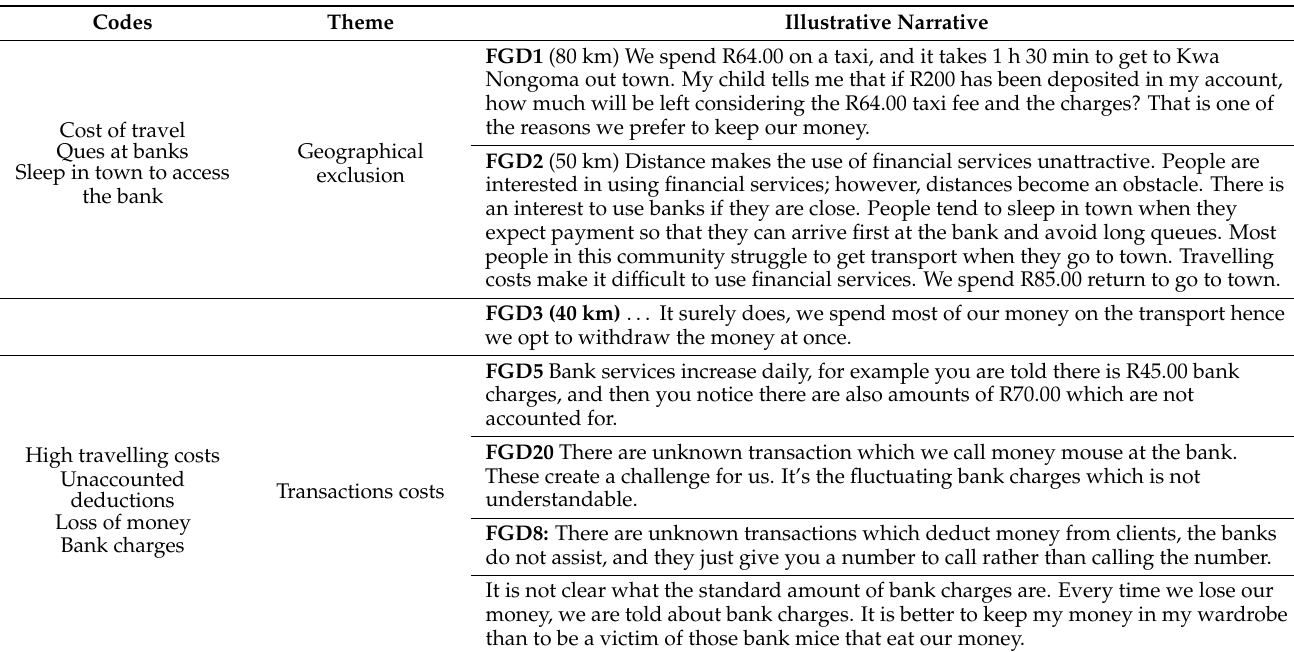
Table 4. Supply-side factors: codes and illustrative